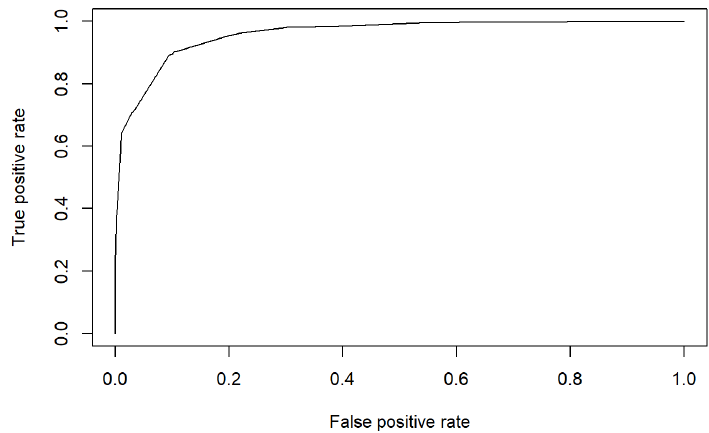
Figure 9. ROC 3 of the estimated model.